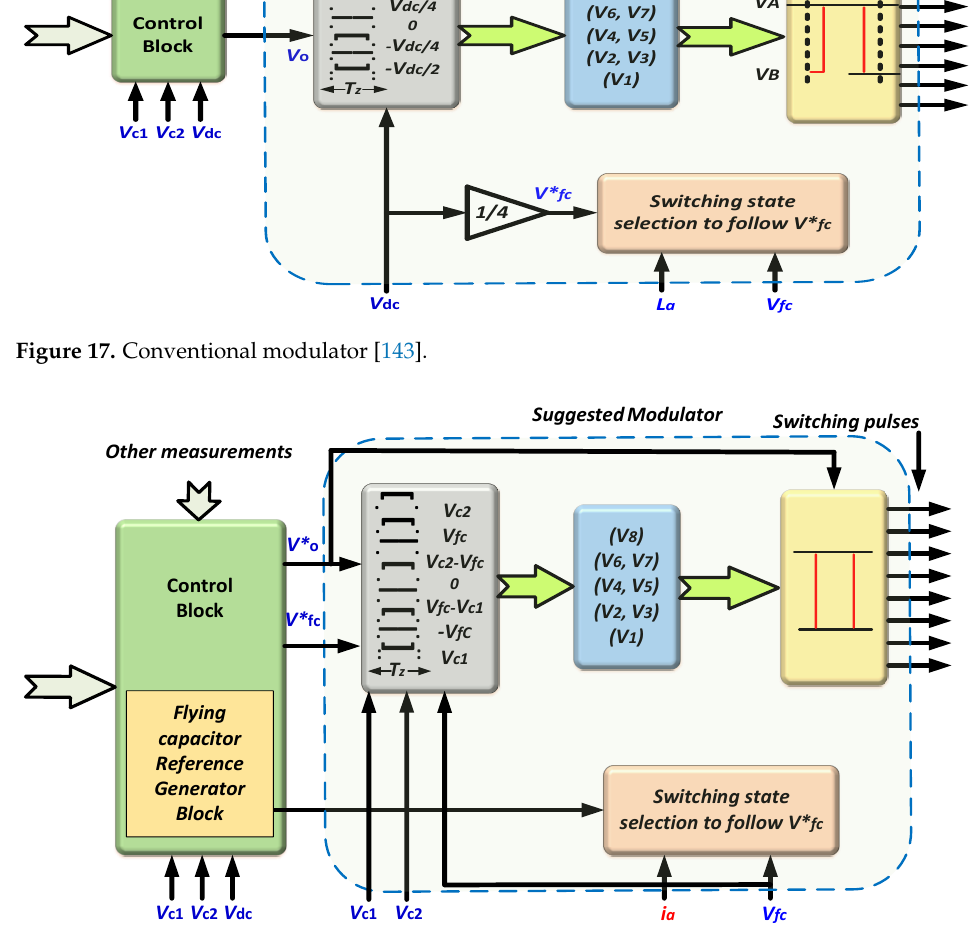
Figure 18. The proposed modulator in [143].